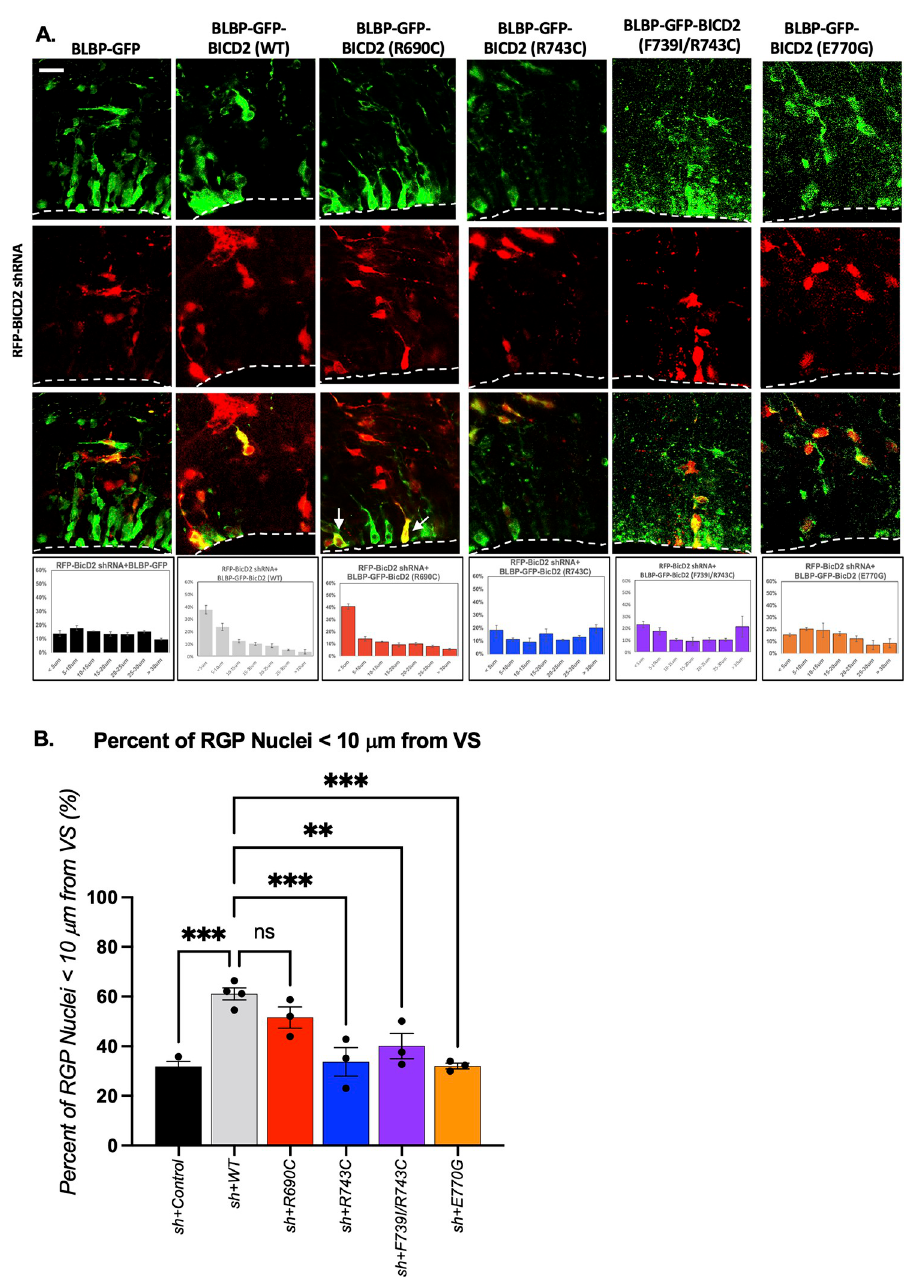
Fig 4. BICD2 mutations with defective RanBP2 binding interferes with apical nuclear migration in RGP cells, in vivo . E16 rat brain was in utero co-electroporated with an RFP-BICD2 shRNA [5] and GFP-tagged wildtype/mutant BICD2 cDNAs under control of the BLBP promoter for RGP specific expression to perform rescue experiments. Representative E20 rat brain slices are shown near the ventricular surface (VS) ( white dashed line). (A) Top panels show green RGP cells expressing the GFP tagged BICD2 wild type or mutant constructs. The middle panels show RFP-BICD2 shRNA expressing cells followed by merged images of the GFP and RFP channels. The corresponding histograms of the measured distances from the VS to nuclei of co-electroporated cells are shown in the bottom panels. White arrows point to two RGP nuclei, expressing both the shRNA and the BicD2 constructs at ventricular surface. Detailed experimental design and the measuring method can be found in S4 Fig. Scale bar = 10 μ m. (B) Mean percent of the RGP nuclei within 10 μ m of the VS are plotted as bar graphs. All error bars are S.E.M from at least 3 different brains. Each black dot in panel B represents one embryonic rat brain. One-way ANOVA with Dunnette’s test was performed and the statistical significance is marked in black. (ns = not significant; �� p < 0.01; ��� p <